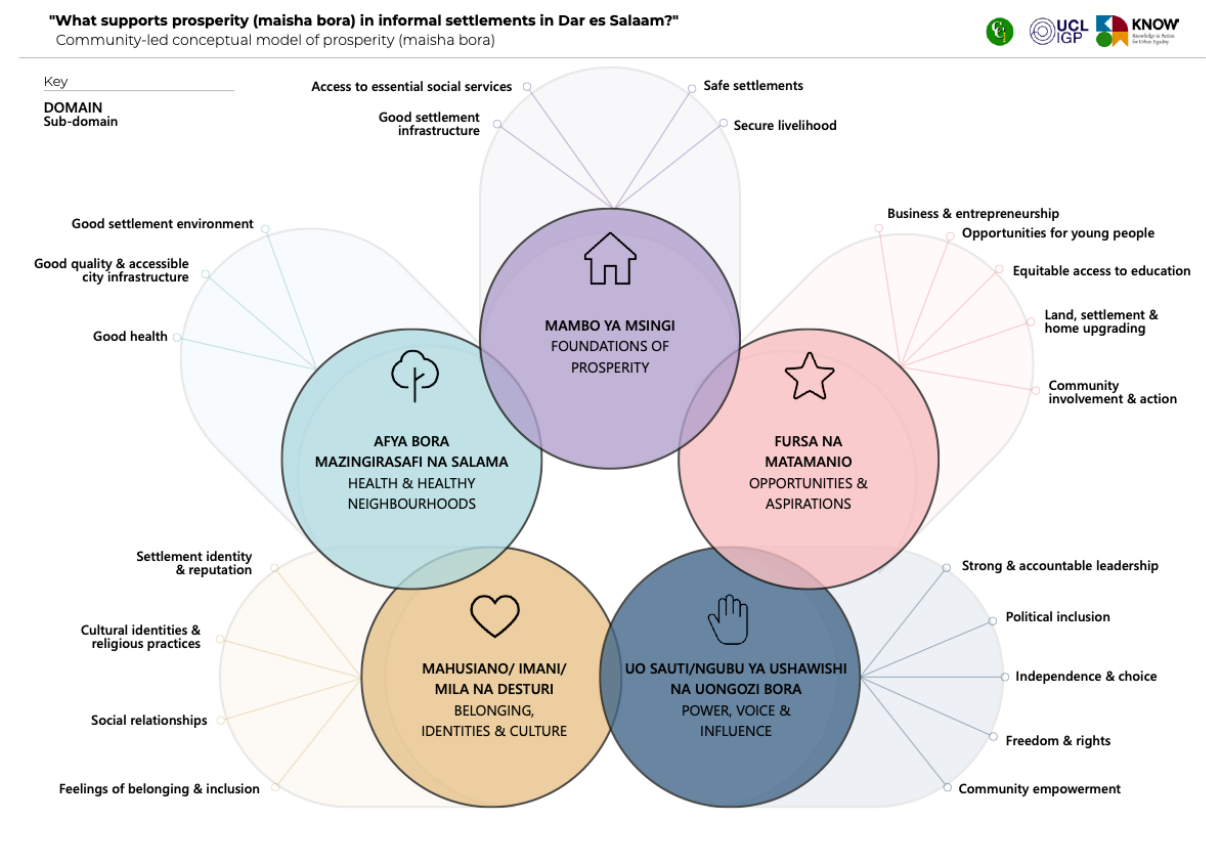
Figure 6. Maisha bora model Dar es Salaam. Based on the unpublished CCI and IGP KNOW Project output of 2019. Urban Planning, 2020, Volume 5, Issue 3, Pages